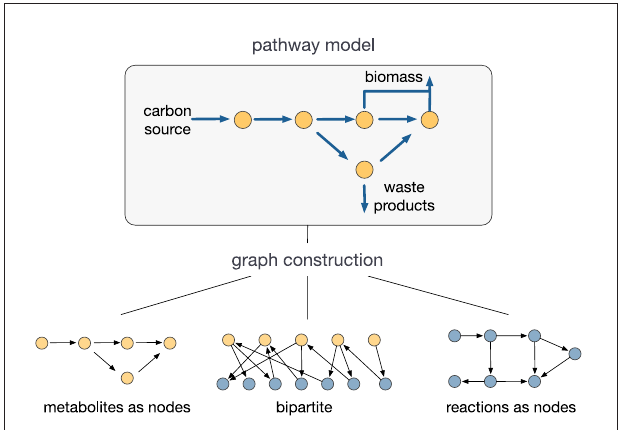
FIGURE 1 | Graph constructions for metabolic networks. Depending on how nodes and edges are defined, several graphs can be built from a single metabolic model (Palsson, 2015). The conclusions drawn from graph analyses depend strongly on the choice of graph. The lack of consensus on the construction of such graphs is a key challenge for the use of network science in metabolic